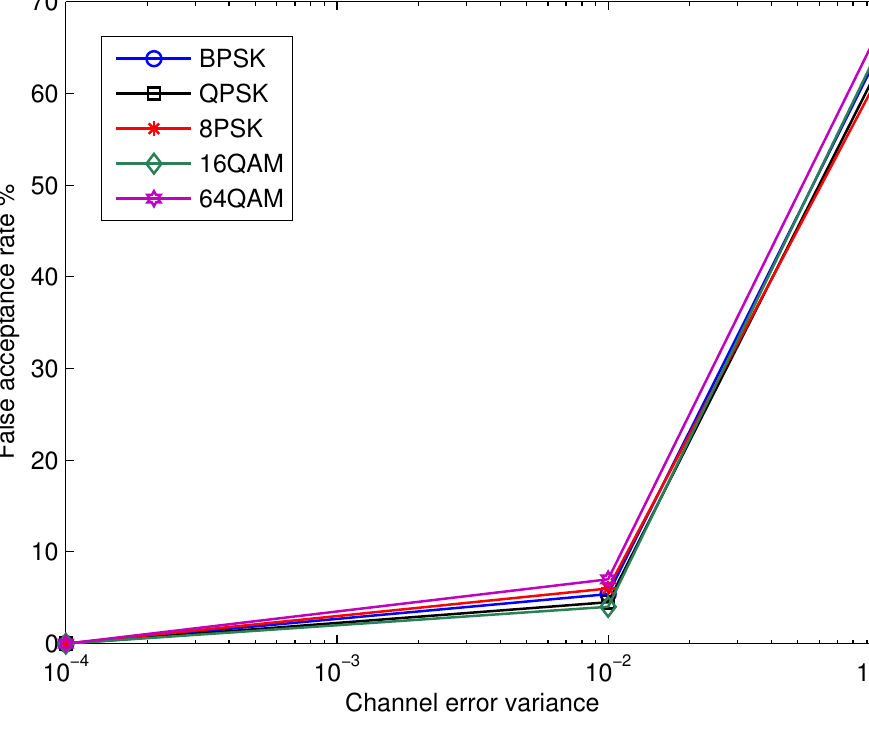
Figure 9. False acceptance rate as a function of the channel error variance at SNR = 12